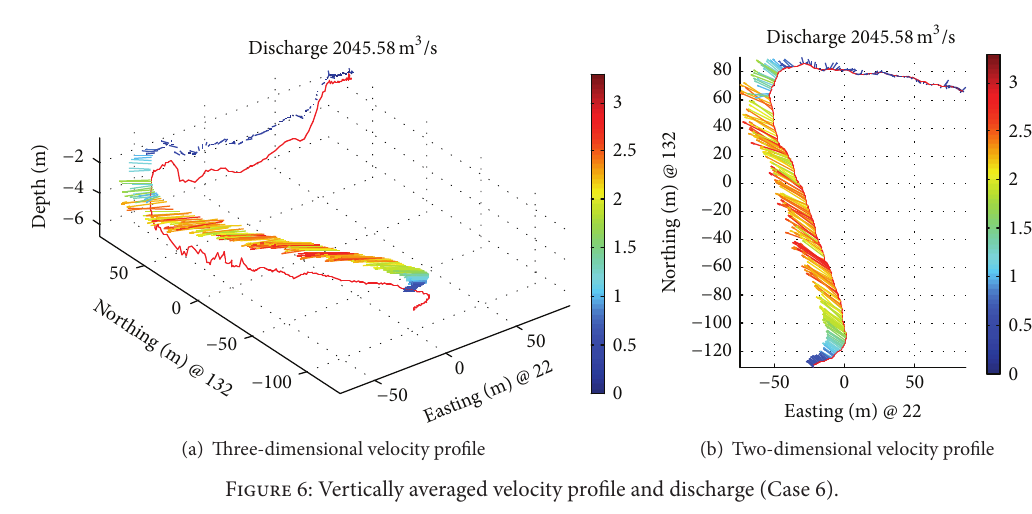
Figure 6: Vertically averaged velocity profile and discharge (Case 6).